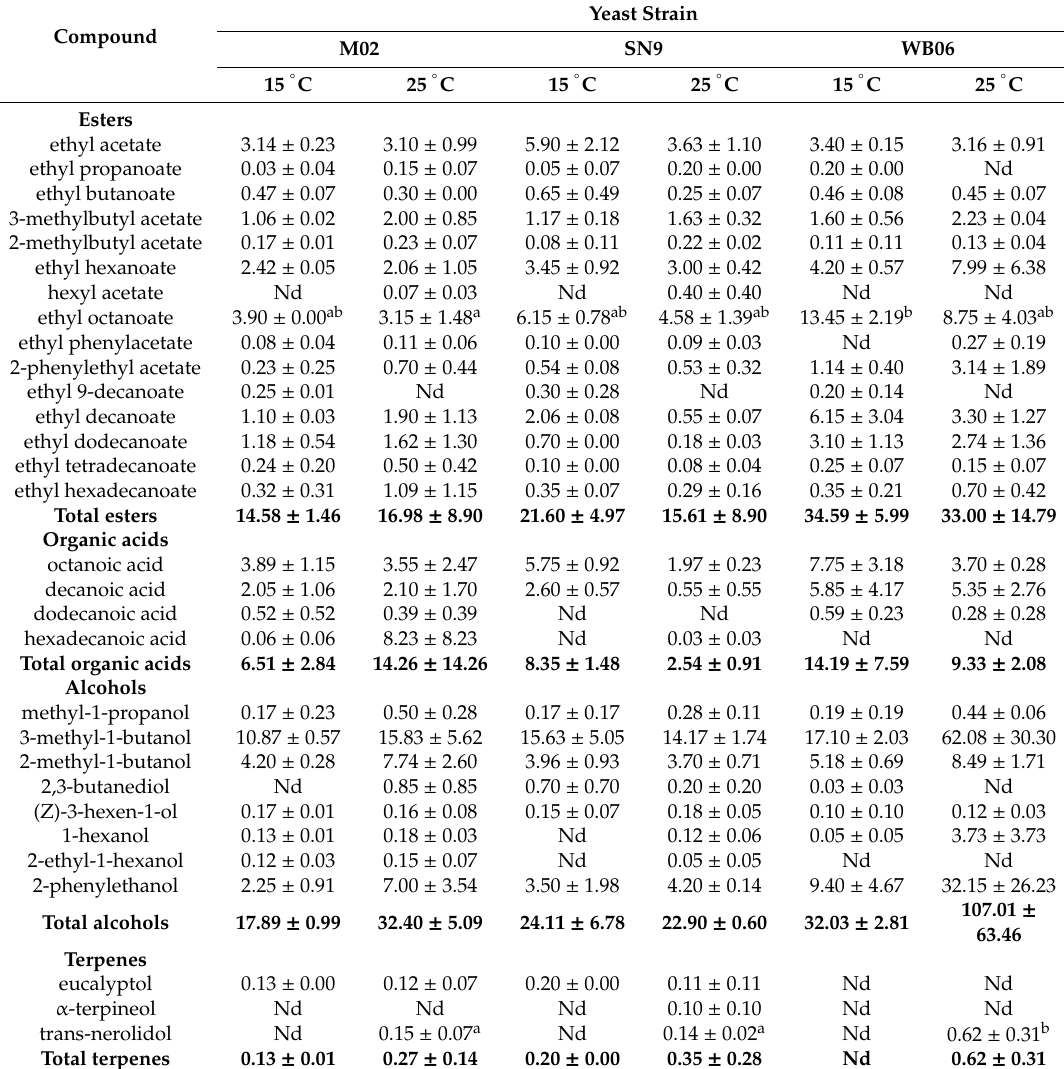
Table 3. E ff ect of yeast and fermentation temperature on aroma-related compounds (mg L -1 ) of pomegranate alcoholic beverages as detected by GC / MS